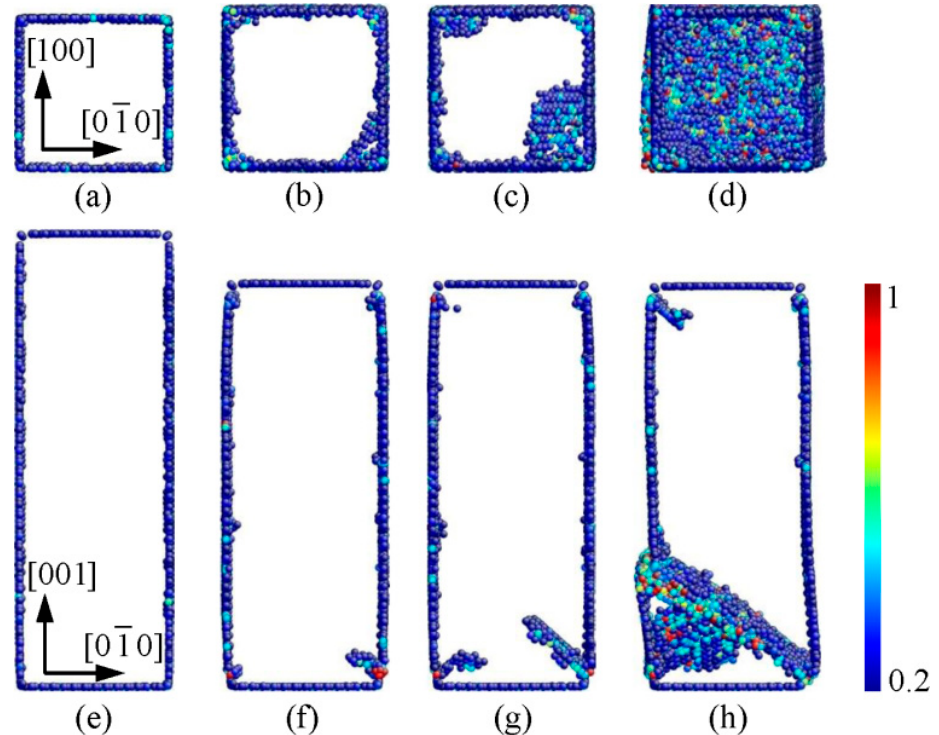
Figure 4. Atomistic configurations of the <100>/{100} silicon nanowire with width of 7.7 nm at different compressive strain levels. Atoms are colored according to the local von Mises shear strain invariant [41], with blue indicating low value and red representing high value. ( a ) ε = 0, ( b ) ε = 0.111, ( c ) ε = 0.113, ( d ) ε = 0.116, ( e ) ε = 0, ( f ) ε = 0.111, ( g ) ε = 0.113 and ( h ) ε = 0.116. For clarity, only atoms with local von Mises shear strain invariant larger than 0.2 are shown.